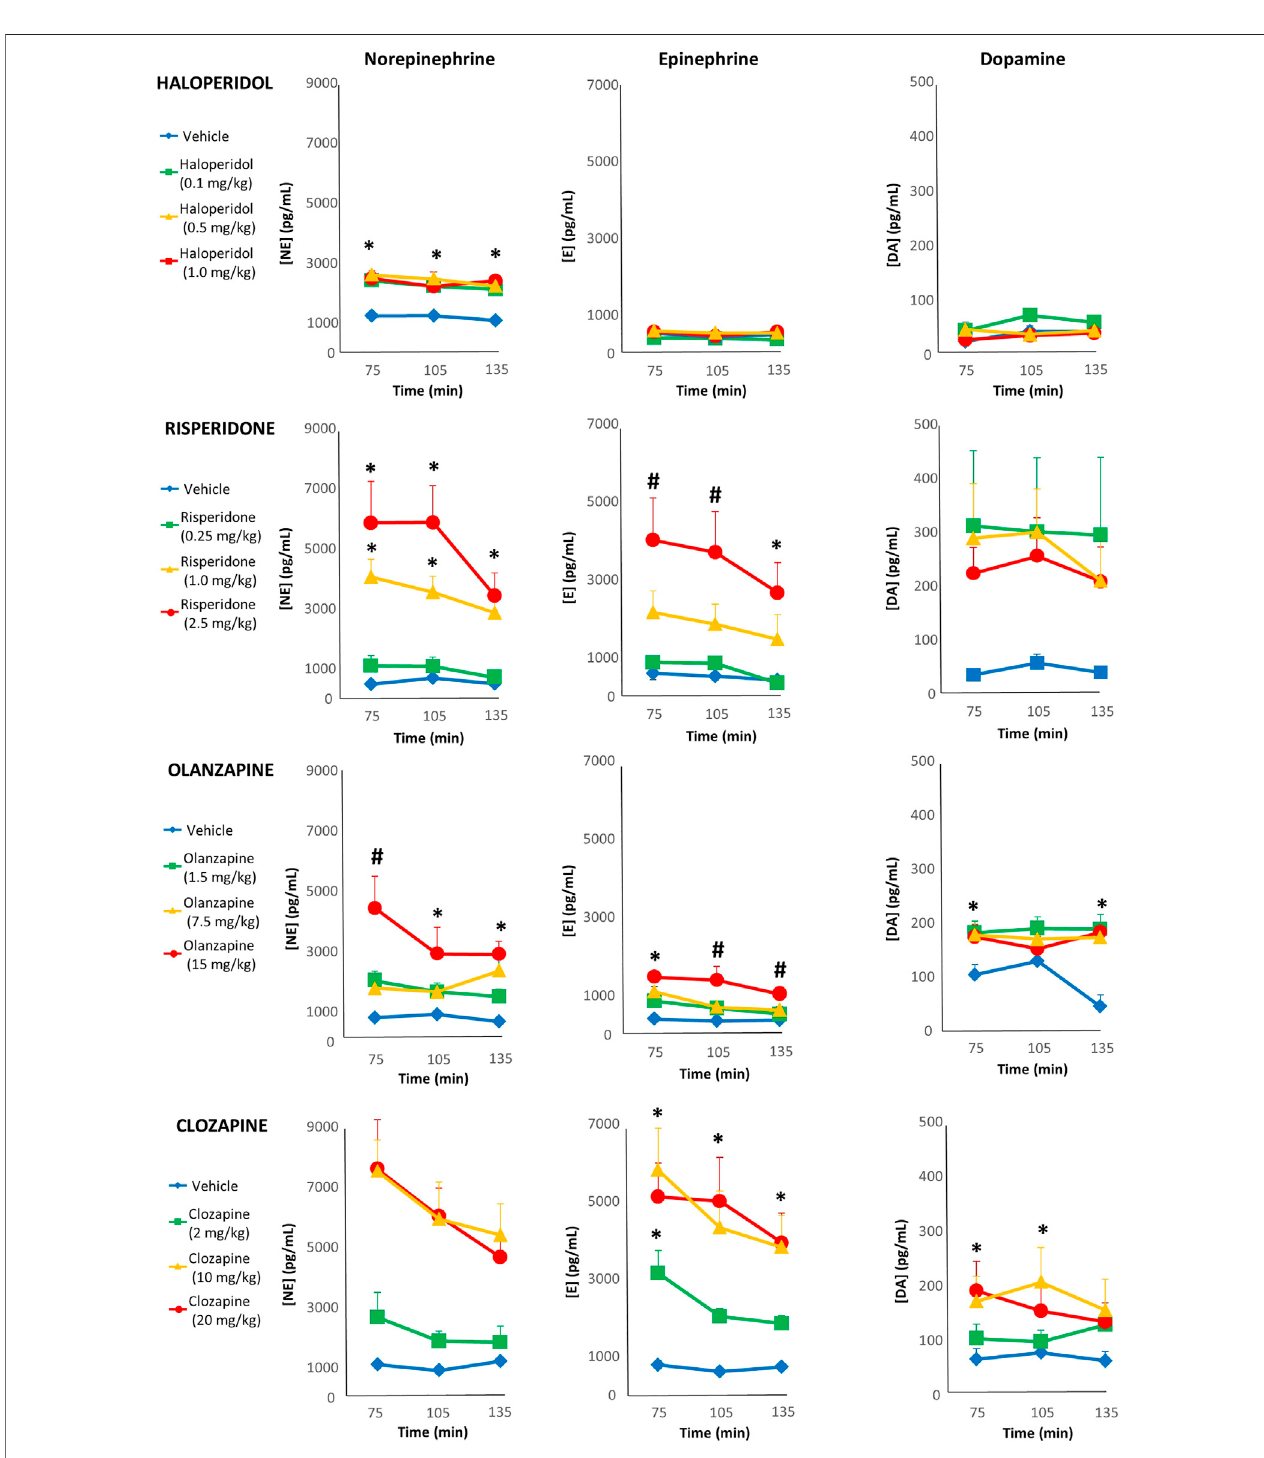
FIGURE 3 | Acute changes in plasma catecholamines after antipsychotic drug treatment in adult female rats. Animals ( n = 10 – 11 per group) received a single injectionofvehicleorhaloperidol(.1,.5,1.0 mg/kg,s.c),risperidone(.25,1.0,2.5 mg/kg,s.c),olanzapine(1.5,7.5,15.0 mg/kg,s.c)orclozapine(2.0,10.0,20.0 mg/kg, s.c). Separate blood draws were collected 75, 105 and 135 min after drug treatment. Samples were anlayzed by HPLC-ED, and concentrations of norepinephrine (left column), epiphrine (midle column) and dopamine (right column) were determined. Values are expressed in group means ± SEM. * statistically signi fi cant difference compared to vehicle group, p < .05; # statistically signi fi cant difference compared to all other groups, p < .05.